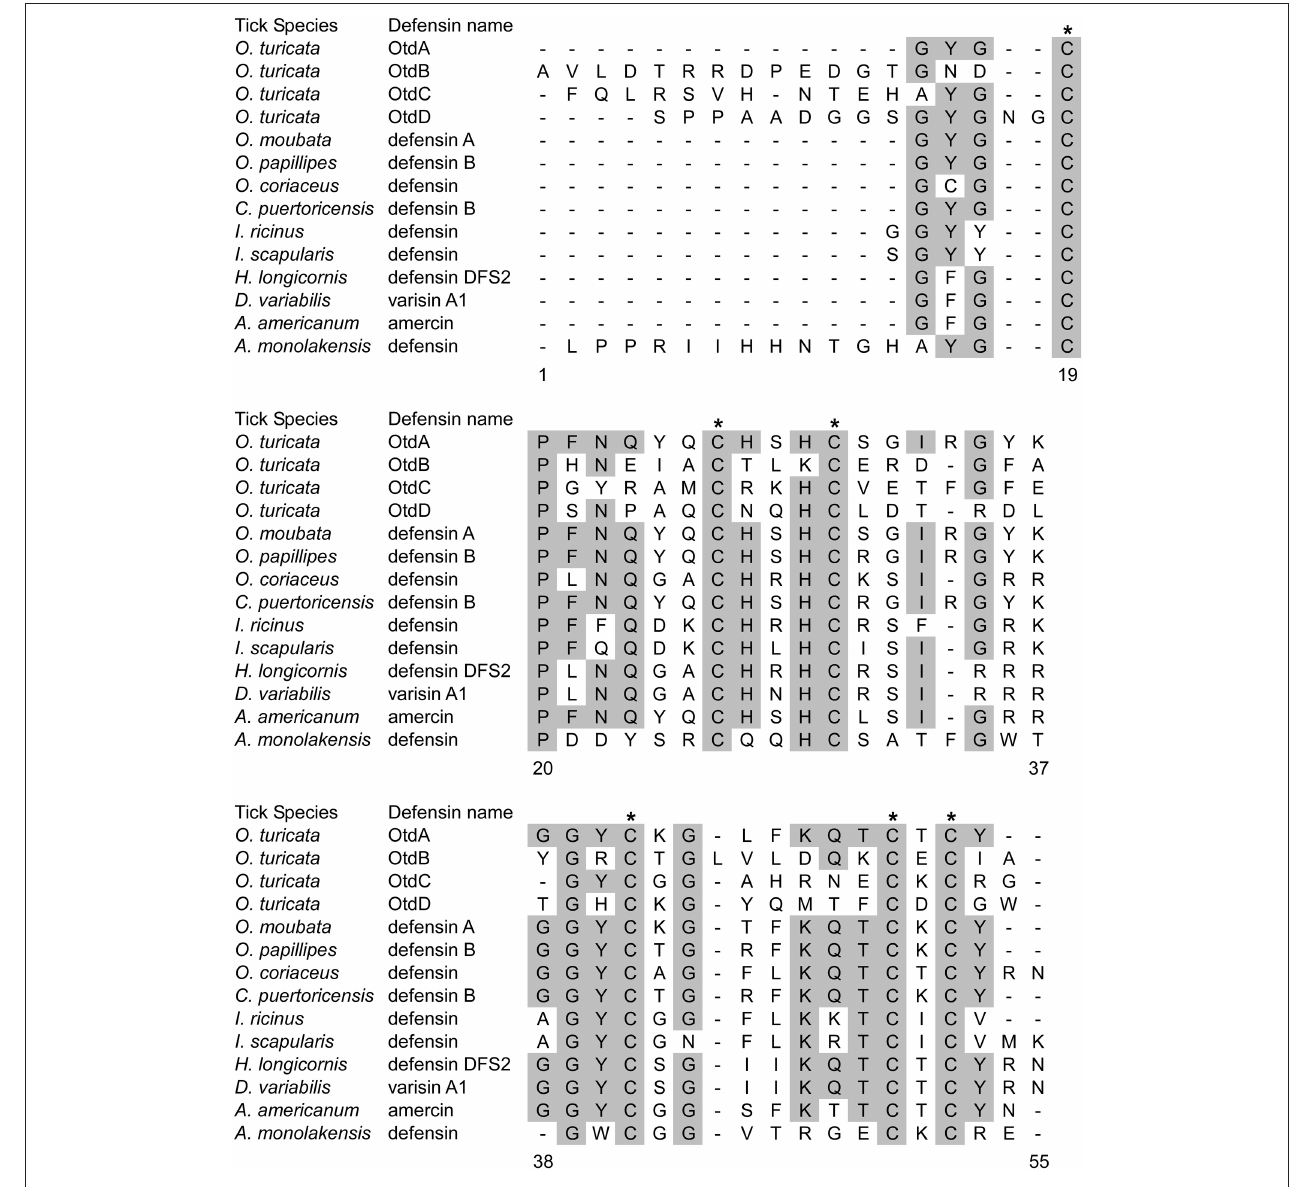
FIGURE 1 | Alignment of mature tick defensin amino acid sequences. Amino acid sequences for the mature peptide of 10 tick defensins and our four putative defensins were obtained from NCBI and RACE sequencing, respectively. Alignment was performed using ClustalW in MEGAX 10.0.5. Shaded amino acids indicate amino acids that are shared among at least 50% of the sequences. Asterisks indicated the cysteines common to defensins. Numbers indicate the position of amino acids.